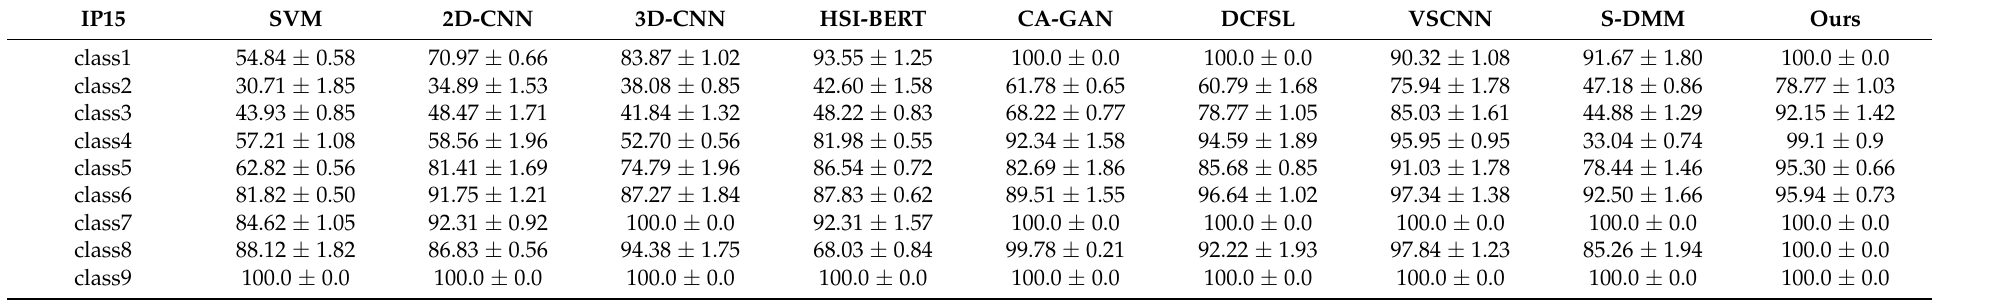
Table 11. The classification results of our proposed and other leading methods on the Indian Pines dataset